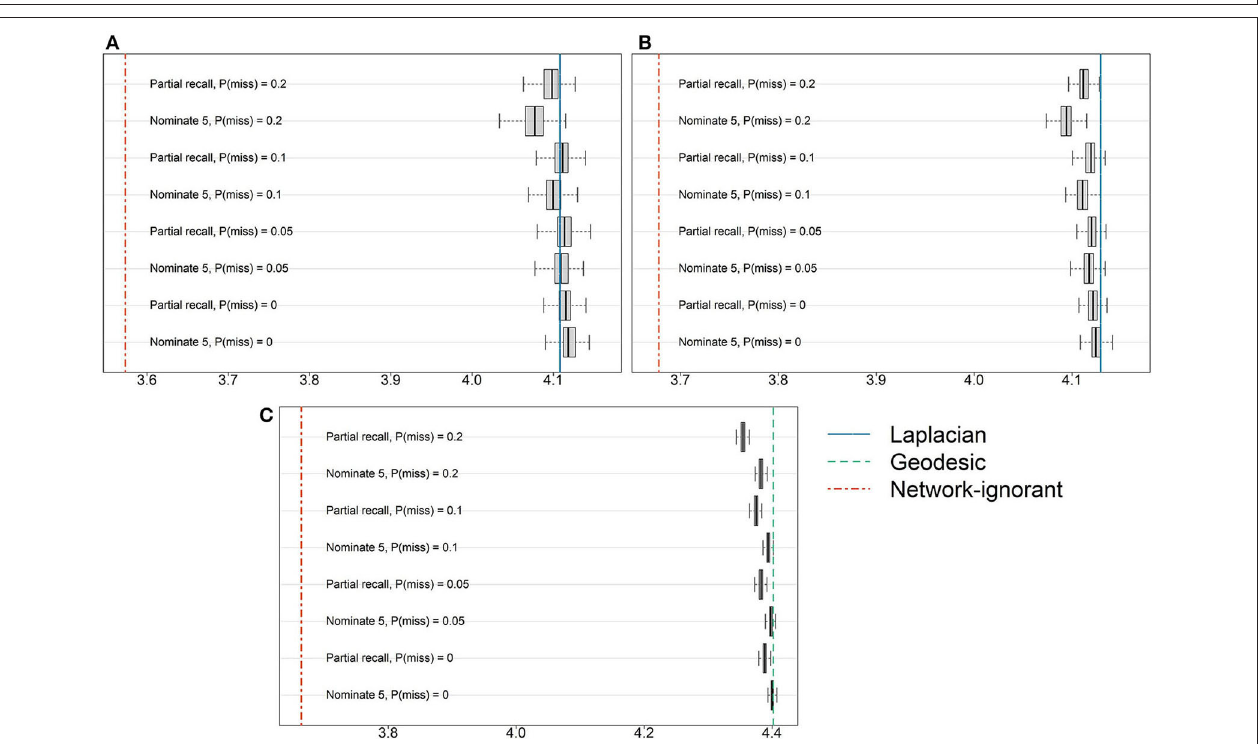
FIGURE 1 | Values of the objective function Q ( Z ) (vertical axis) vs. the pool size K (horizontal axis) for (A) AH495, (B) AH2587, and (C) ERGM10000. Values of Q are given using Algorithm 1 based on the Laplacian eigenvectors, Algorithm 2 based on geodesic distances, and using random pool assignments.